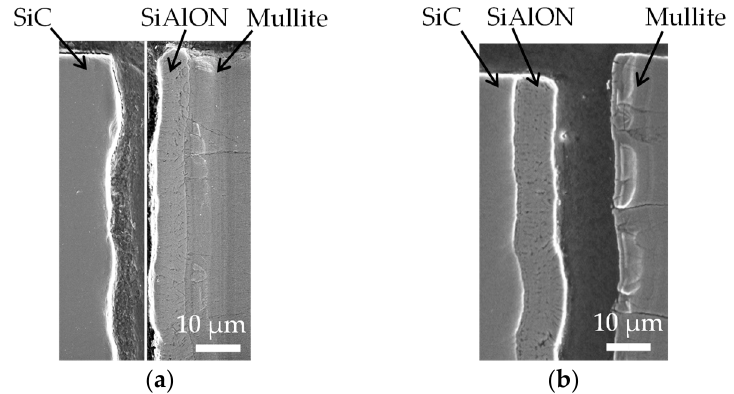
Figure 10. Examples of cross-sectional SEM images of specimens after interface fracture test; Fracture at ( a ) SiC/SiAlON interface and ( b ) SiAlON/mullite interface.